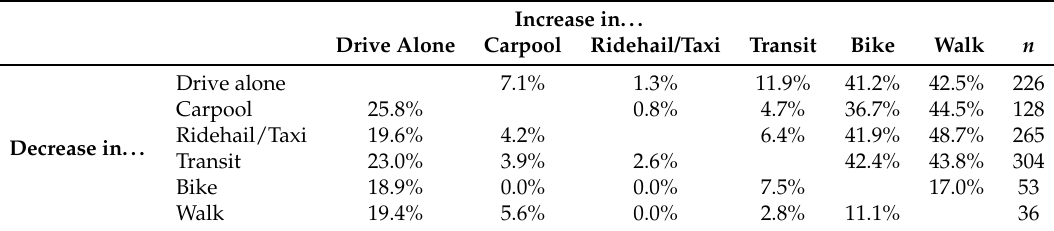
Table 3. Percent of respondents expecting a decrease in one mode who also expect an increase in another mode. Increase in... Drive Alone Carpool Ridehail/Taxi Transit Bike Walk